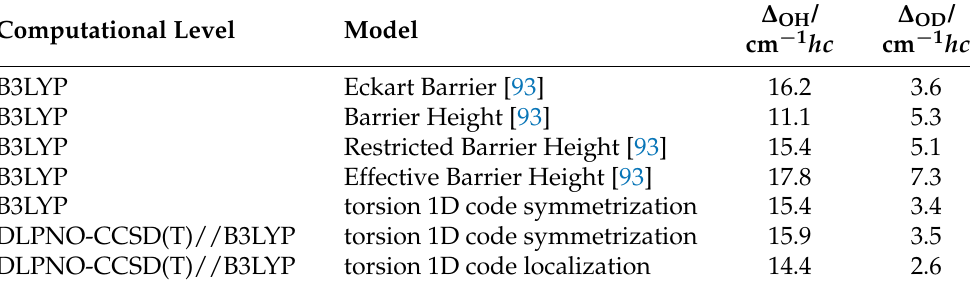
Table 2. Predicted tunneling contributions ∆ to the ground-state torsional splitting of α -fenchol- OH and -OD according to different simple models [93] and the torsion 1D code based on B3LYP- D3(BJ)/may-cc-pVTZ calculations, in part with DLPNO-CCSD(T)/aug-cc-pVQZ corrections. For